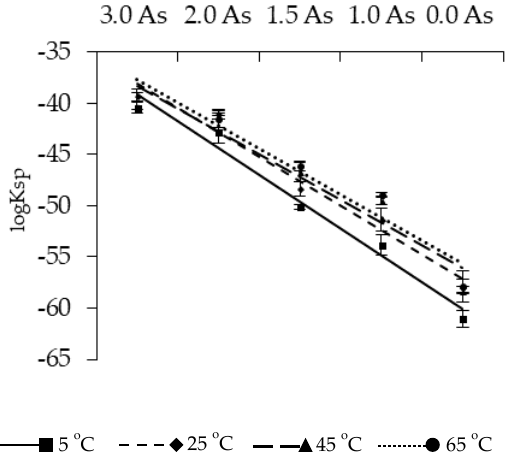
Figure 10. The variability and linear trends of solubility constant K sp in the isomorphic series JBM–HAP at four temperatures: 5, 25, 45, and 65 °C.